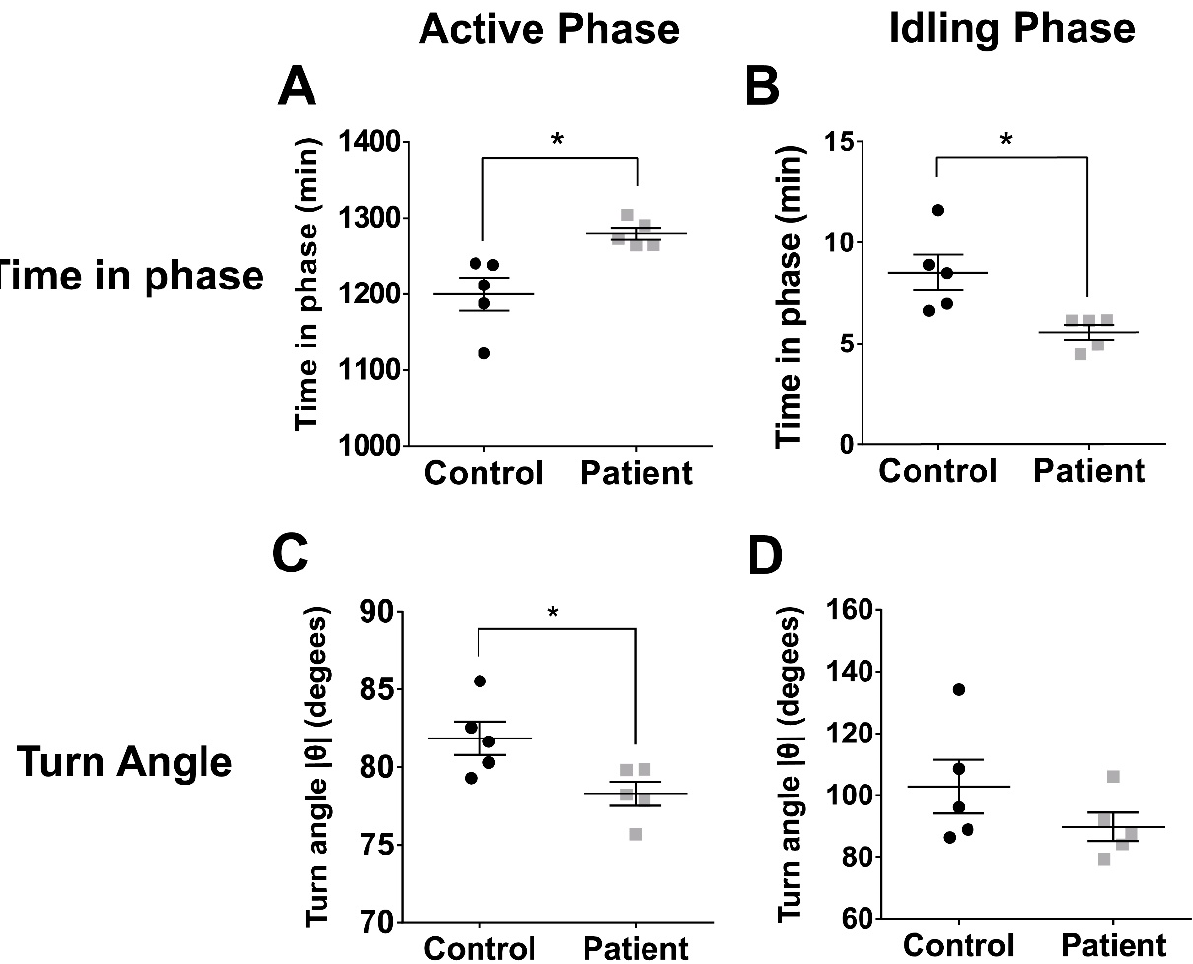
Figure 2. Patient cells were more active and made smaller turns than control cells on uncoated tissue culture plastic. ( A ): Time spent in Active Phase: Symbols represent means of all cells for individuals in each group. Bars represent mean ± SEM for each group. ( B ): Time spent in Idling Phase: Symbols represent means of all cells for individuals in each group. Bars represent mean ± SEM for each group. ( C ): Turn Angle following Active Phase: Symbols represent means of all cells for individuals in each group. Bars represent mean ± SEM for each group. ( D ): Turn Angle following Idling Phase: Symbols represent means of all cells for individuals in each group. Bars represent mean ± SEM for each group. * = p < 0.05, t -test.